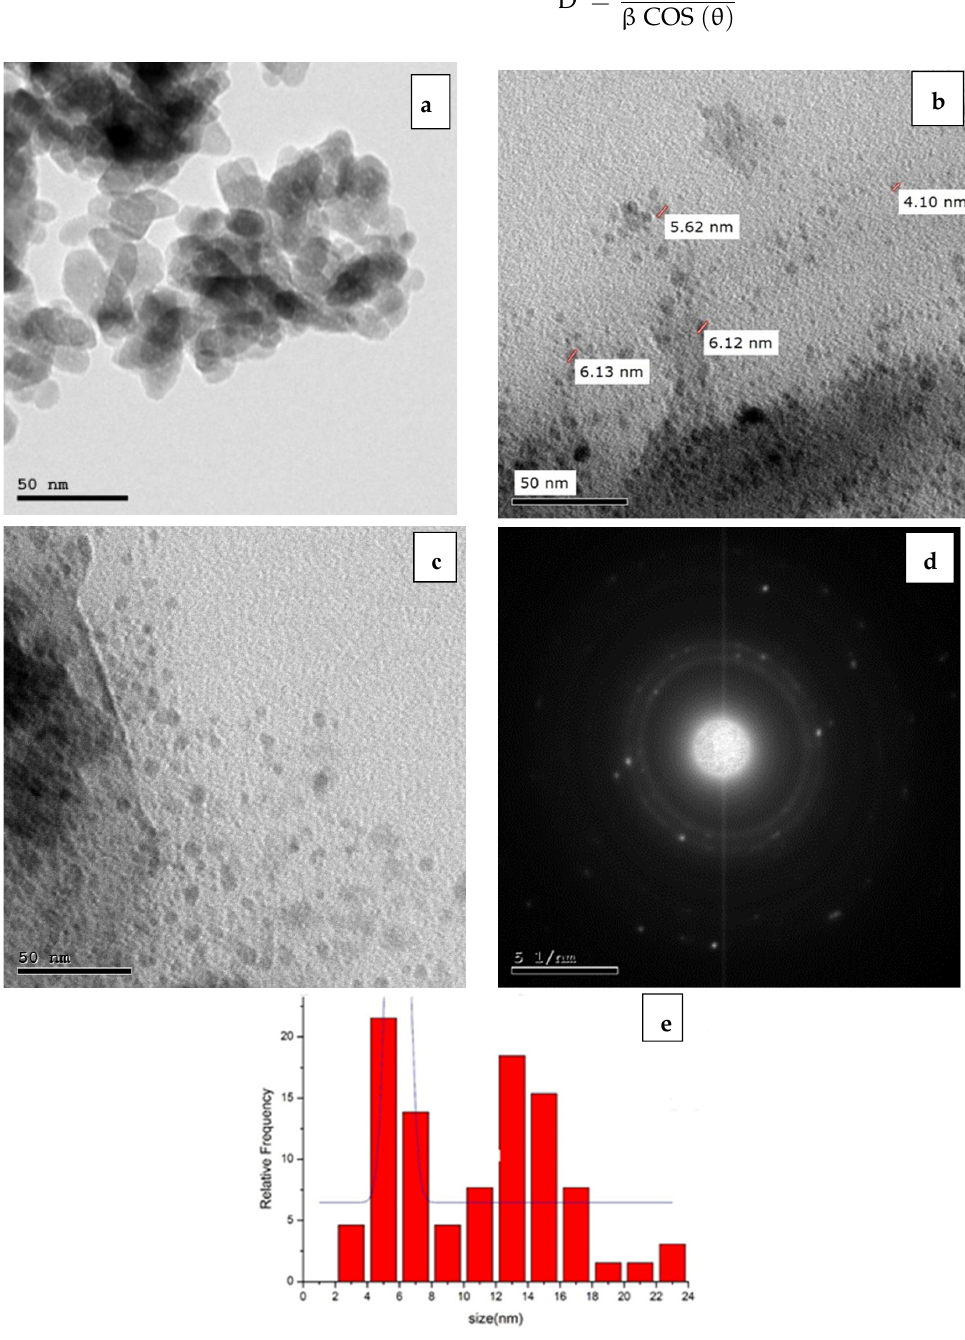
Figure 10. TEM images for ncCuAg electrodeposited on SS surface from the optimum bath at 1.72 mA cm − 2 , 10 min, 27 °C, and the histogram of particle size distribution.